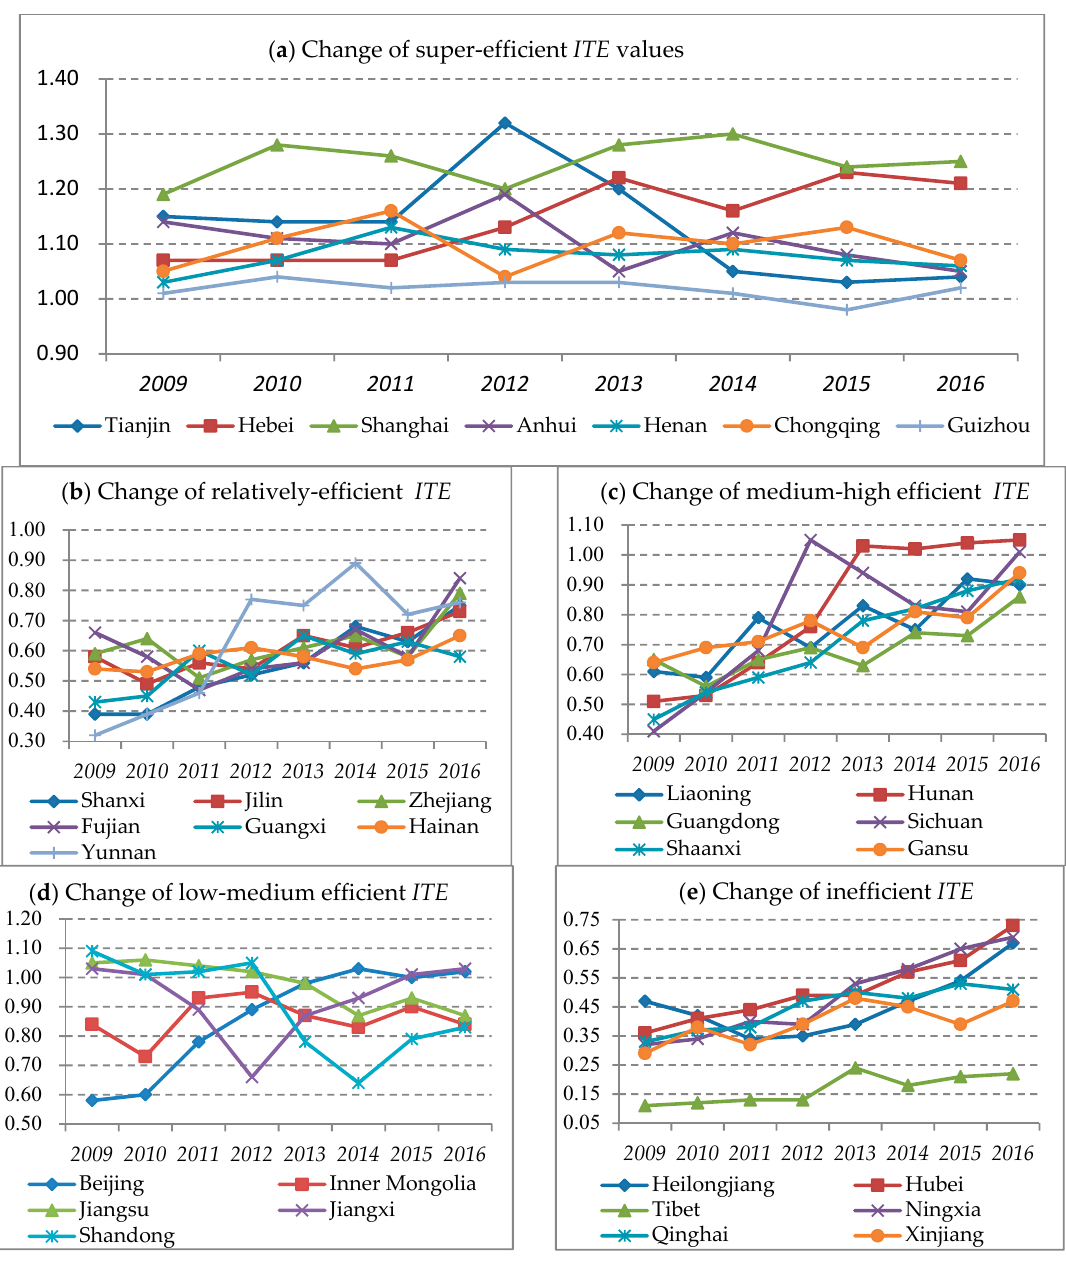
Figure 4. Changes of ITE for each province.